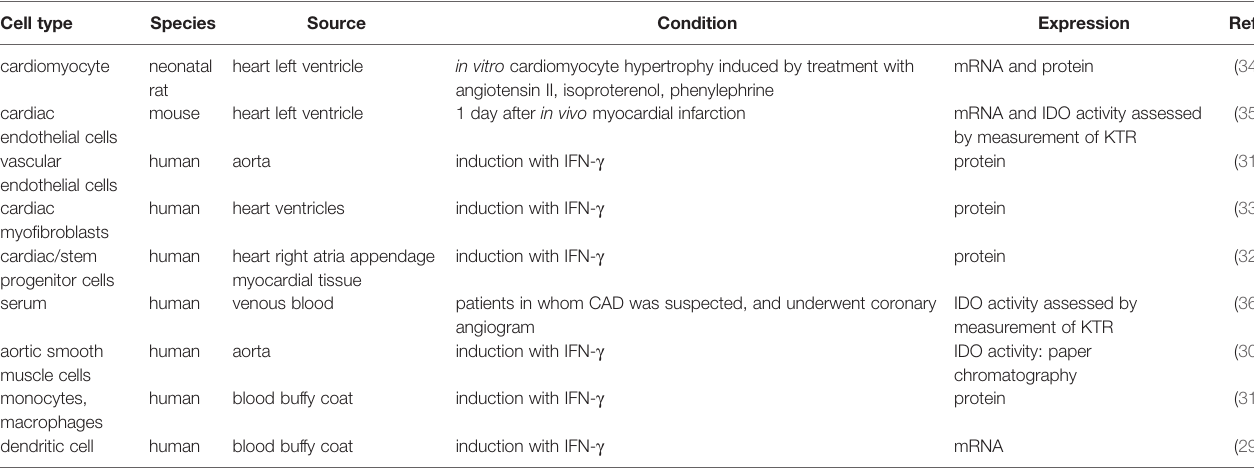
TABLE 1 | IDO expression under cardiovascular disease related